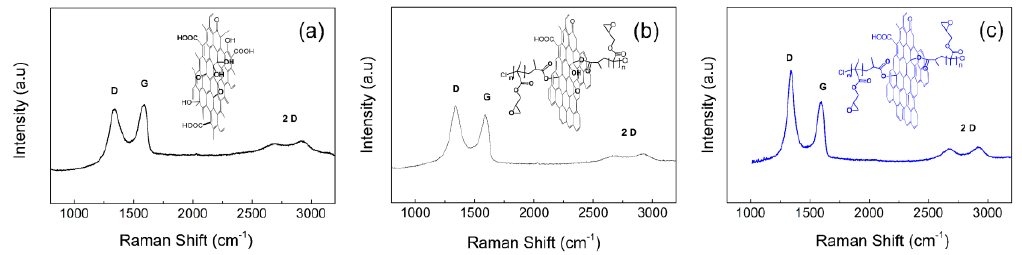
Figure 4. Raman spectra of the neat GO ( a ) GO-PGMA 1; ( b ) GO-PGMA 2; and ( c ) particles and corresponding chemical structures.